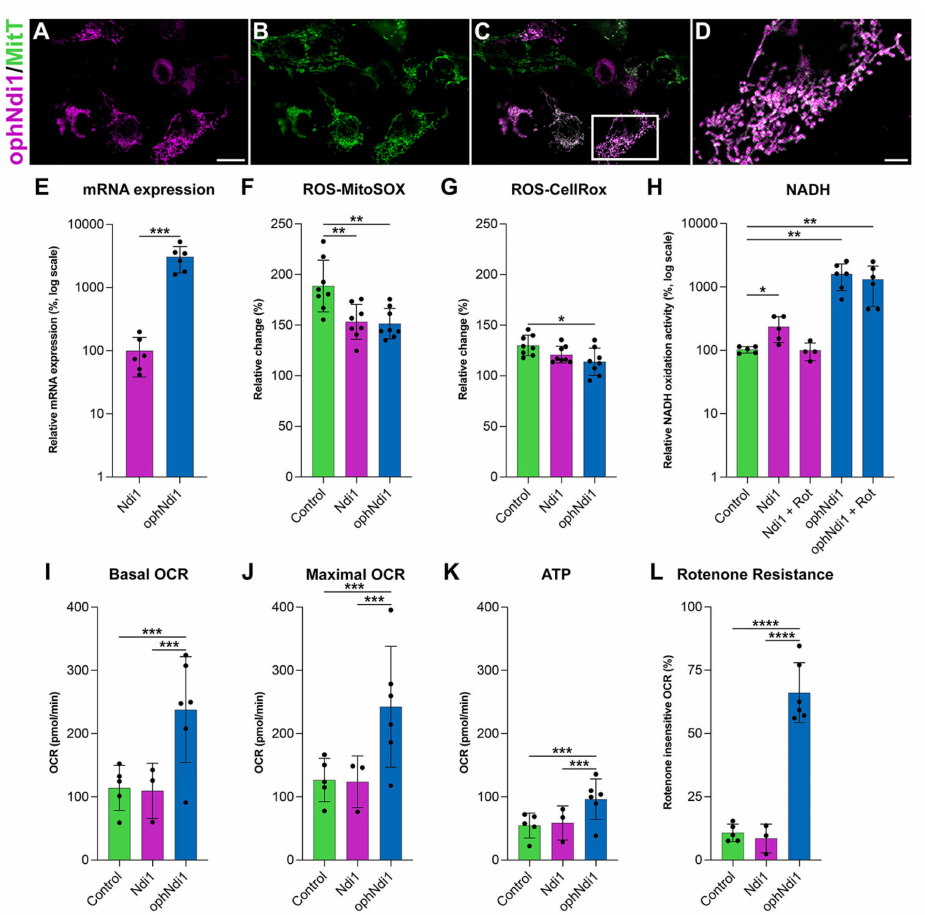
Figure 1. Functional analyses of ophNdi1 in vitro. To establish mitochondrial localisation of ophNdi1, HEK293 cells were co-transfected with 0.5 µ g HA-tagged ophNdi1 and analysed 48 h later using Cy3-labelled HA immunocytochemistry ( A ) and MitoTracker™ ( B ); ophNdi1 and MitoTracker™ are co-localised ( C , D ). Bioenergetic profiles were evaluated in HEK293 cells transfected with 1 µ g pAAV-MCS (control, green bars), 1 µ g pAAV-NDI1 (pink bars) or the copy number equivalent of pAAV-ophNdi1 (blue bars) ( E – H ); or transduced with AAV-NDI1 (pink bars) or AAV-ophNdi1 (blue bars) at an MOI 3.4 × 10 5 and compared to untransduced cells (green bars) ( I , J ). Bar charts represent: ( E ) Relative mRNA expression levels in HEK293 cells harvested 24 h post-transfection of pAAV- NDI1 or pAAV-ophNdi1. RNA was isolated and mRNA expression analysed by RT-qPCR. Relative expression of NDI1 was assigned a value of 100. ( F ) Cellular (CellRox™) and ( G ) mitochondrial (MitoSox™) ROS levels measured 48 h post-transfection. Cells were insulted with 5 nM rotenone for 24 h prior to analysis or left un-insulted. The percentage increase in ROS between rotenone-insulted and un-insulted cells is shown. ( H ) The rate of NADH oxidation analysed 72 h days post-transfection, normalised to protein. Null transfected control cells, without rotenone addition, were taken to be 100%. ( I – L ) Mitochondrial stress test (Seahorse XFe96 Analyser, Agilent) was performed 48 h post- transduction of AAV-NDI1 or AAV-ophNdi1 ( n = 5). Oligomycin (1.0 µ M), FCCP (1.0 µ M), rotenone (0.5 µ M) and antimycin A (0.5 µ M) were injected sequentially and the resultant oxygen consumption rates (OCRs) normalised to protein. Bar charts represent: ( I ) Basal OCR, ( J ) Maximal OCR, ( K ) ATP production, ( L ) Rotenone-insensitive OCR. Error bars represent SD values, * p < 0.05, ** p < 0.01, *** p < 0.001, **** p < 0.0001 ( E : Student’s t -test, F – K : one way ANOVA with Tukey’s multiple comparisons post-hoc test). Scale bar ( A ): 20 µ m, ( D ): 5 µ